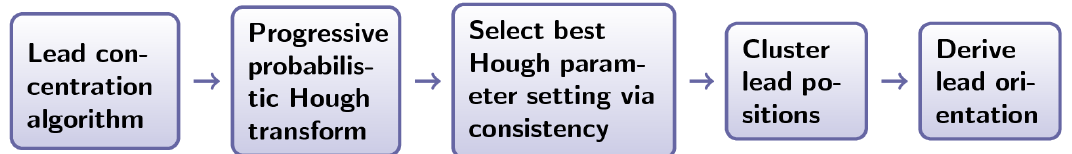
Figure 4. Sketch of the algorithm